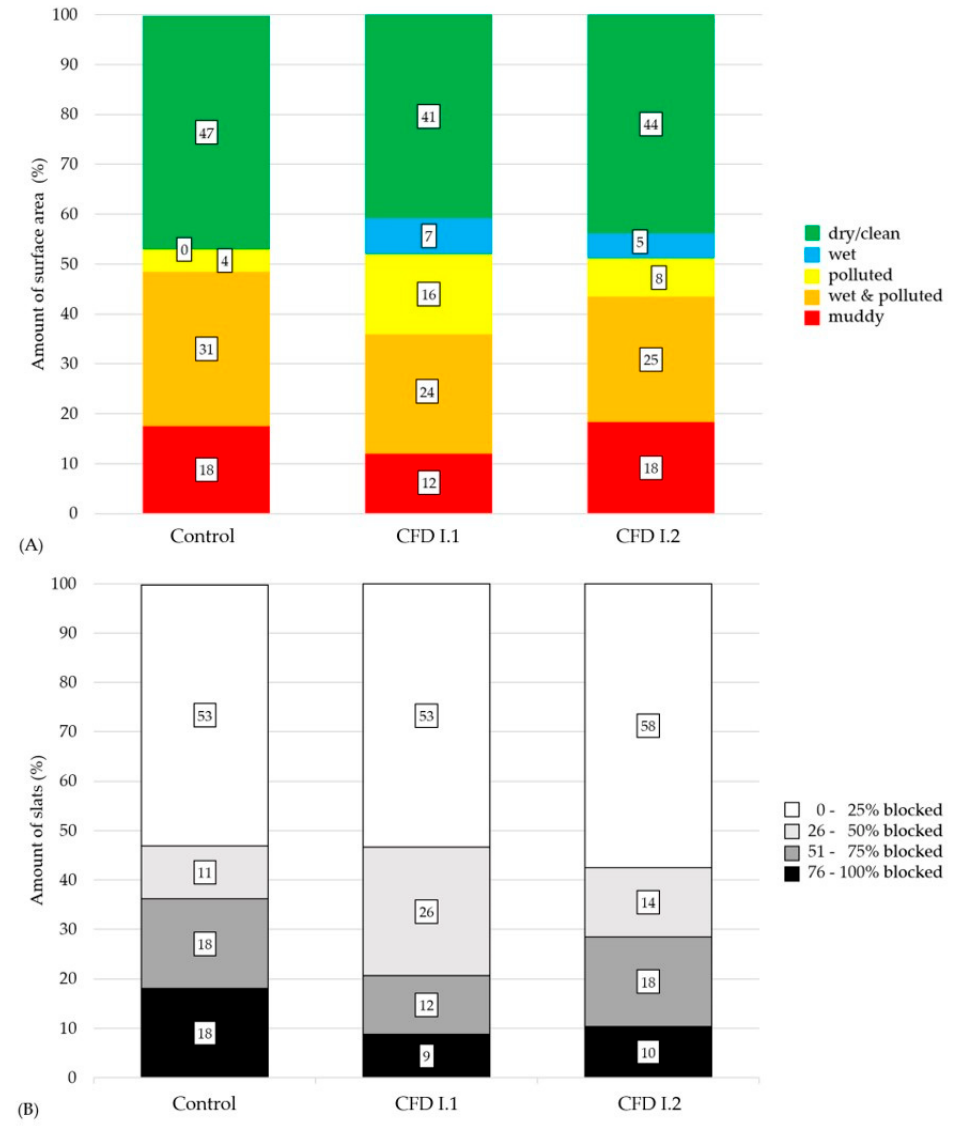
Figure 7. Mean amount of polluted surface area (A) and occluded slats (B) in % for the control and experimental groups (pen I.1 and I.2). Figure follows [38]. experimental groups (pen I.1 and I.2). Figure follows